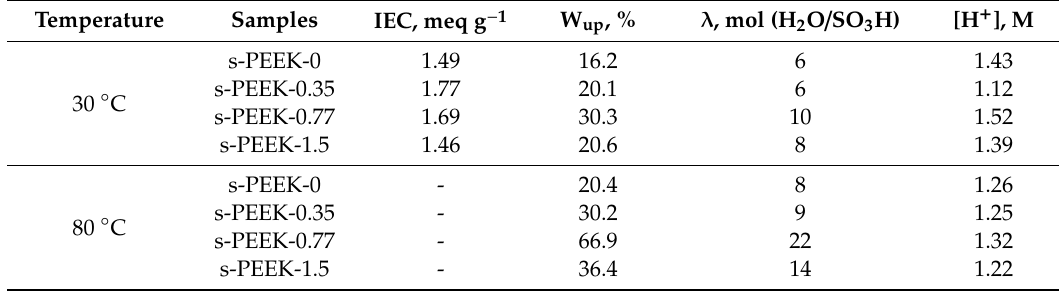
Table 2. Ion exchange capacity (IEC) W up %, λ and [H + ] of the four membranes at di ff erent temperatures.